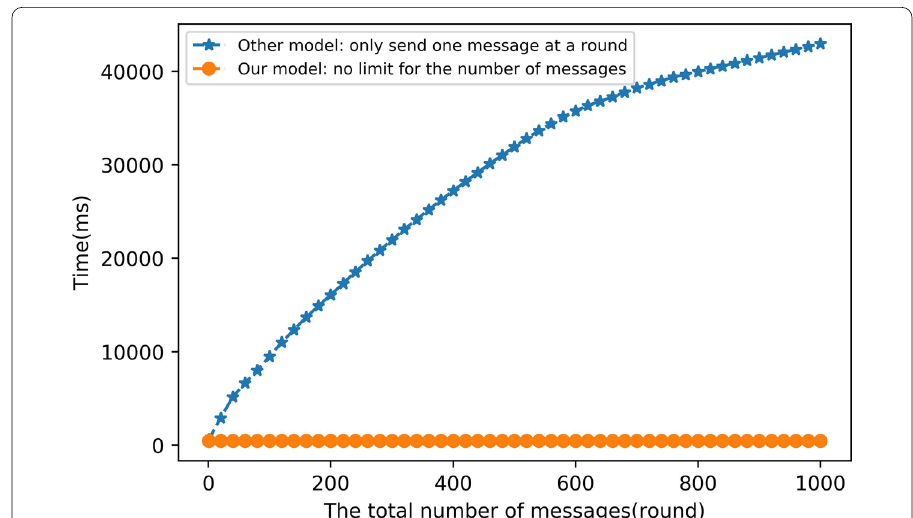
Fig. 2 Communication consumption. This shows the communication consumption of our model and other anonymous communication model which limits the number of